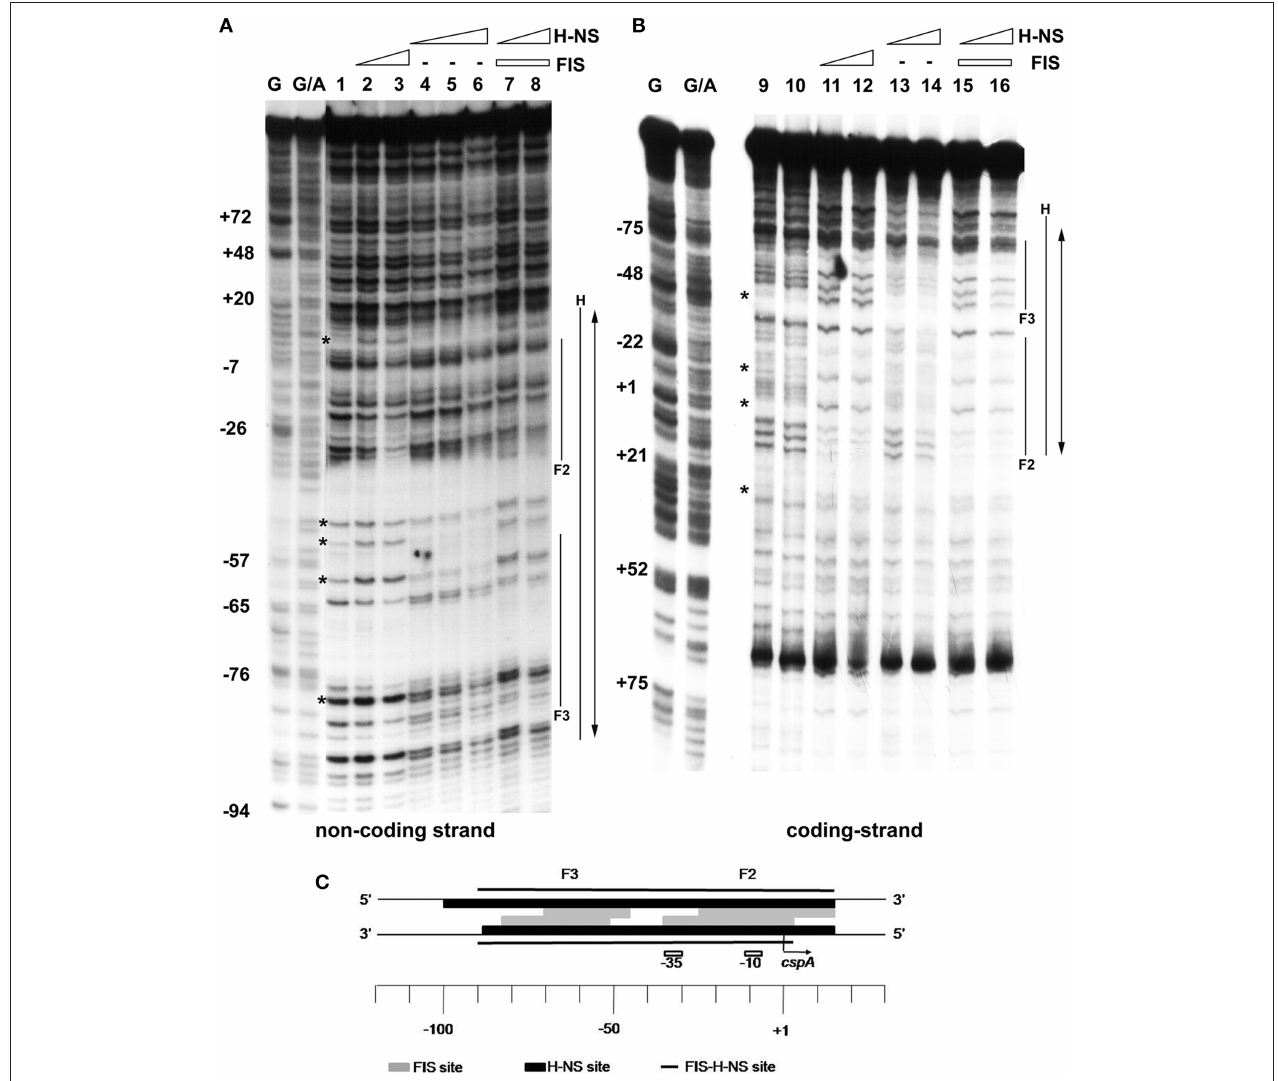
FIGURE 3 | Mapping of FIS and H-NS binding sites on cspA promoter region by DNase I footprinting. Footprinting analysis was carried out on both non-coding strand (A) and coding strand (B) of a 310 bp DNA fragment corresponding to cspA promoter in the presence of the following FIS and HNS dimeric concentrations: no proteins, lanes 1, 9, and 10; 278nM FIS, lanes 2 and 11; 555nM FIS, lanes 3 and 12; 93nM H-NS, lanes 4 and 13; 185nM H-NS, lanes 5 and 14; 277nM H-NS, lane 6; 278nM FIS and 93nM H-NS, lanes 7 and 15; 278nM FIS and 185nM H-NS, lanes 8 and 16. FIS and H-NS sites are indicated by solid lines while the double-headed arrows show protections resulting from the concomitant bond of FIS and H-NS. Sites hypersensitive to DNase I due to FIS-DNA interaction are indicated by asterisk. G and G+A represent the Maxam and Gilbert sequencing reactions. Localization of FIS (gray boxes), H-NS (black boxes), and FIS-H-NS (solid line) binding sites are schematically indicated on cspA promoter region (C)